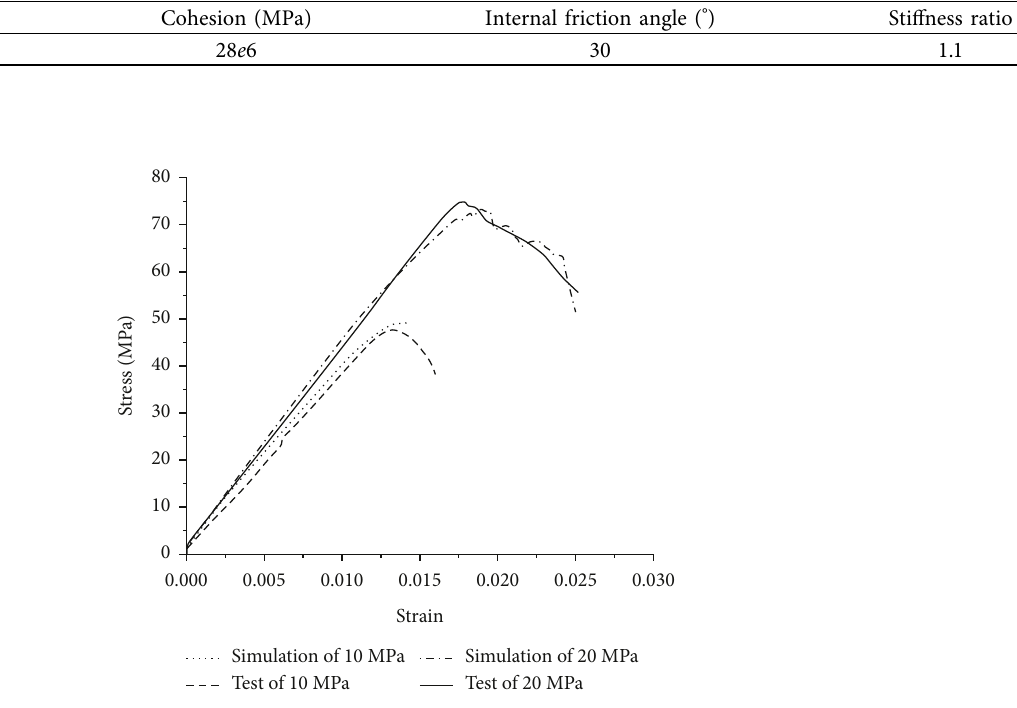
Figure 5: The stress-strain curves from simulations and tests.